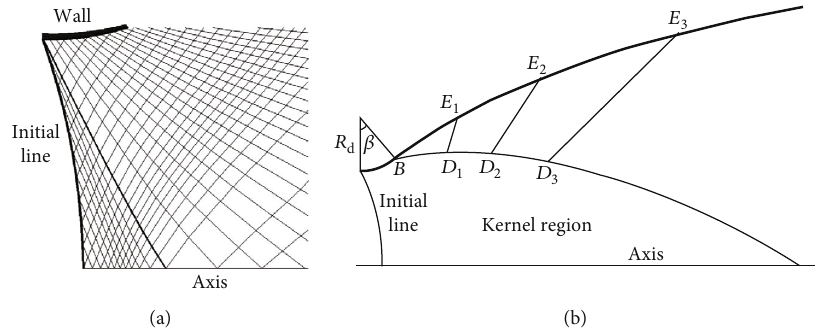
Figure 2: Design procedure of Rao ’ s method: (a) determining the kernel region; (b) determining contour points.